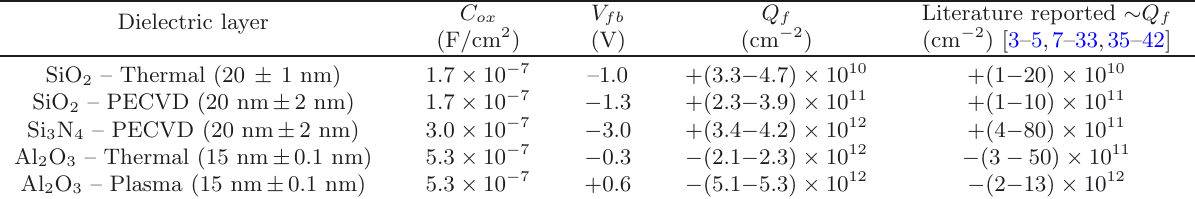
Table 1. Summary of extracted values for fixed charge density (Q f ).